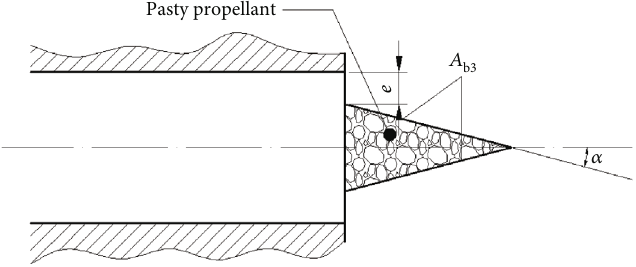
Figure 3: Burning surface of pasty propellant at the burning tail-o ff